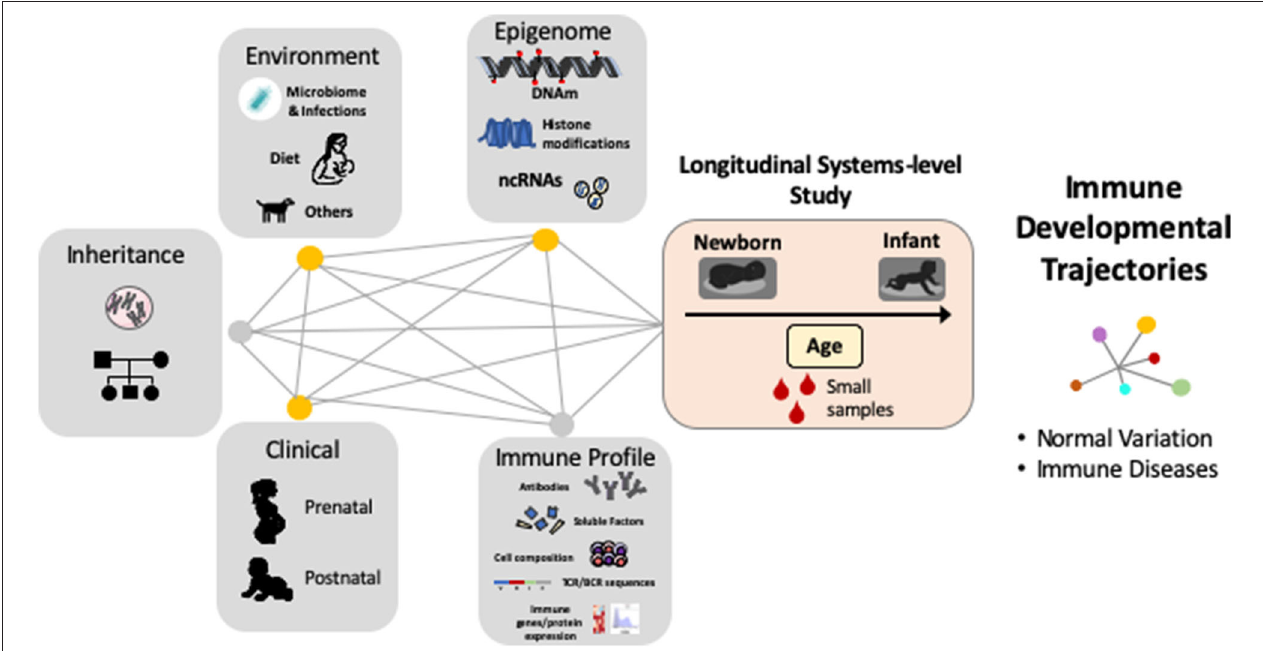
FIGURE 2 | Complex gene, environment and epigenetic interactions shape the human immune system during early life. Systems immunology in longitudinal human-based studies is needed to uncover the “master plan” of human immune development and their relationship with immune diseases. DNAm = DNA methylation, ncRNA = non-coding RNAs, TCR = T-cell receptor, BCR = B-cell